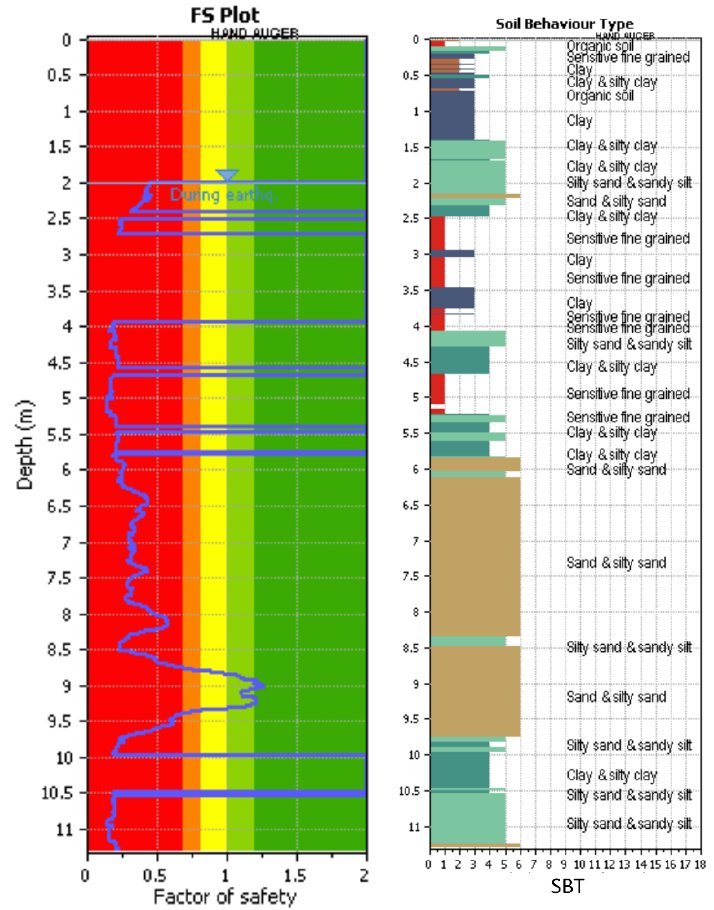
Figure 20. CPT liquefaction triggering results and SBT plot for Site 2-2 (modified from Anderson